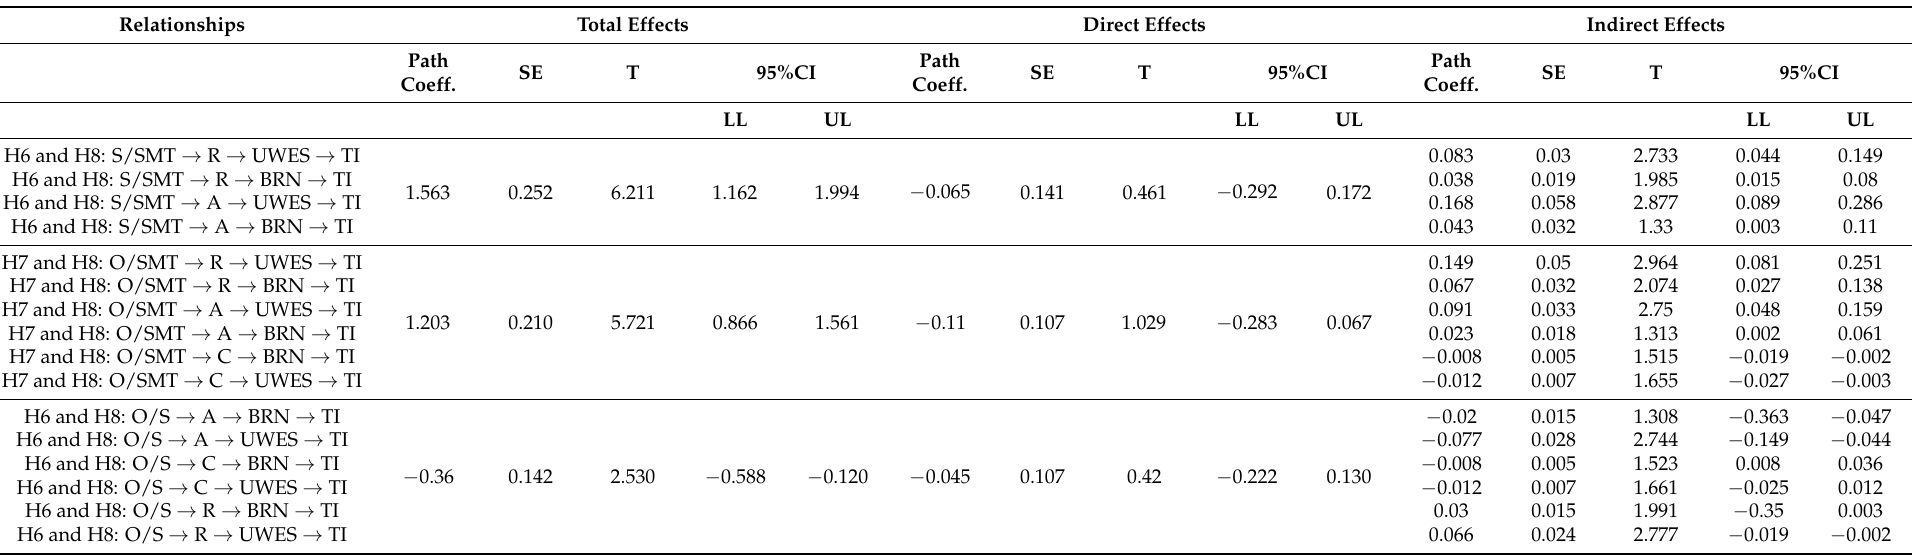
Table 3. Mediation Analysis